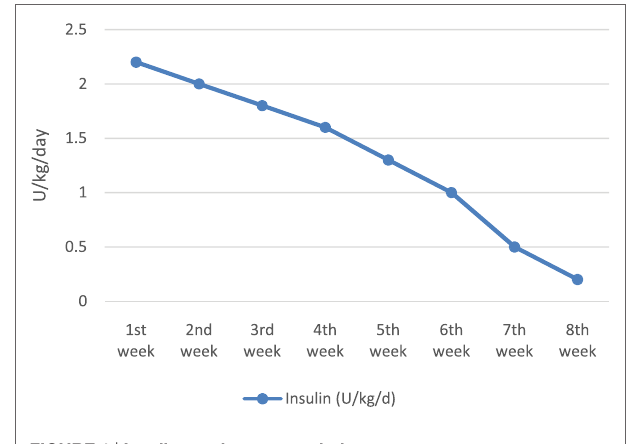
FIGURe 1 | Insulin requirement evolution